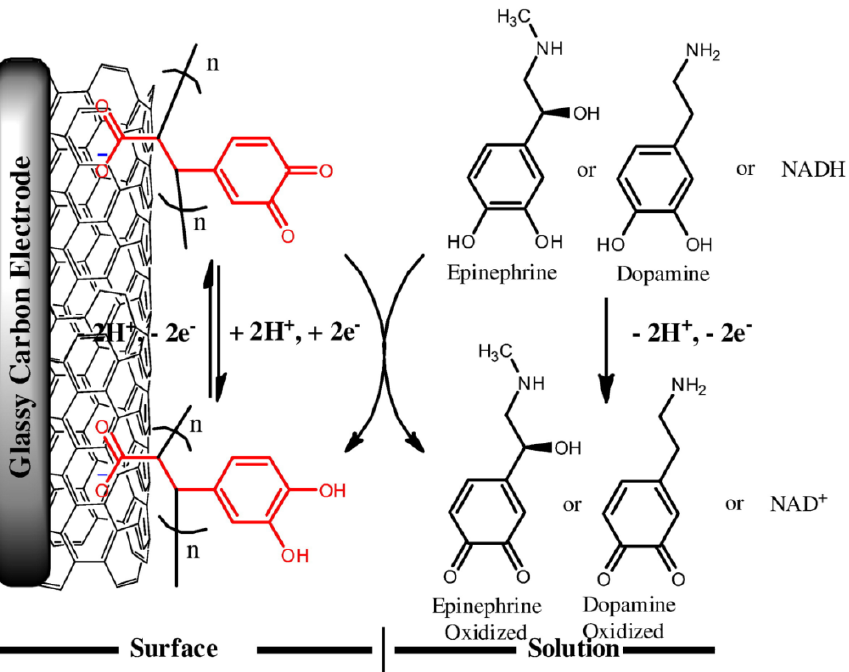
Figure 11. NADH, dopamine, and epinephrine oxidation scheme on poly(ferulic acid)/MWCNTs/GCE. Reprinted from [34] with permission from Elsevier.